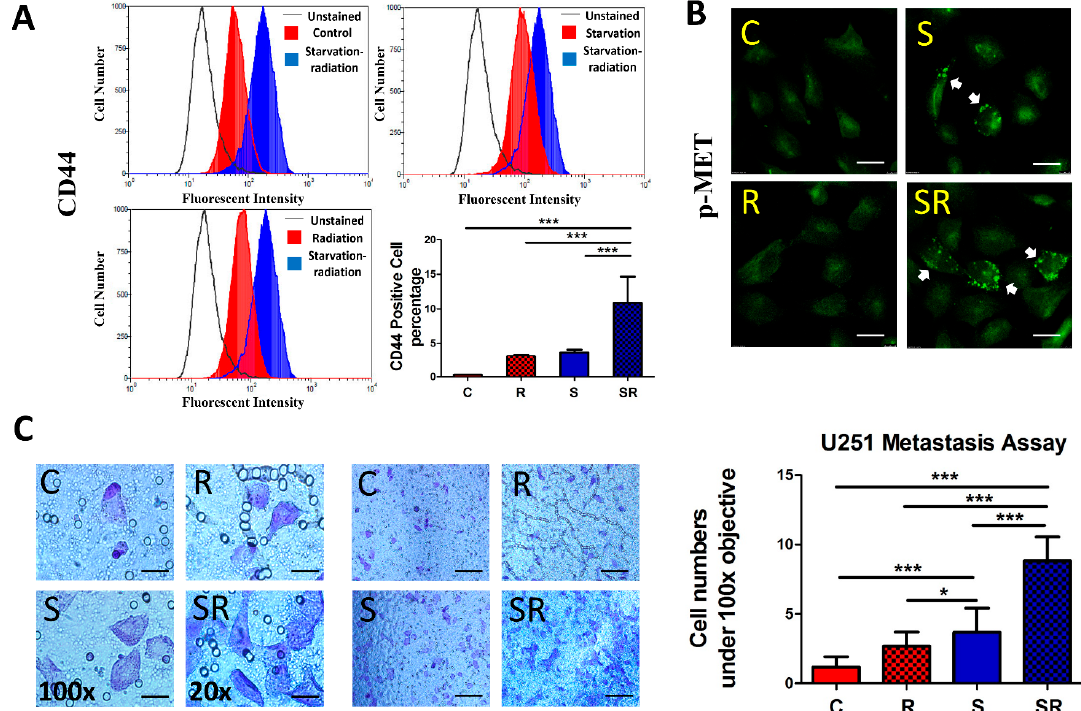
Figure 5. Expression of metastasis biomarkers and metastasis ability in U251 cells were investigated following the four treatments. ( A ) Flow cytometry revealed that the starvation plus radiation group exhibited the highest number of CD44 positive cells; ( B ) Phosphorylated MET signals (white arrow indicating green dots) are expressed in both starved only and starved plus irradiated U251 cells, but the signal is stronger in the latter cells. The scale bar equals 25 μ m; ( C ) Following the metastasis assay, U251 cells were observed under 20× (scale bar equals 100 μ m) and 100× (scale bar equals 20 μ m) magnification, and five random fields were selected to count the metastatic cells. The data represent the means ± S.D. of three independent experiments. Expression levels were compared between treated and non-treated groups. C, Control; R, Radiation; S, starvation; SR, starvation + radiation. * p < 0.01, *** p < 0.0001 versus different treated groups.